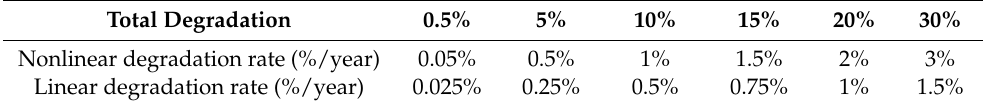
Table 2. Degradation rates of different cases Source: self-elaboration. Total